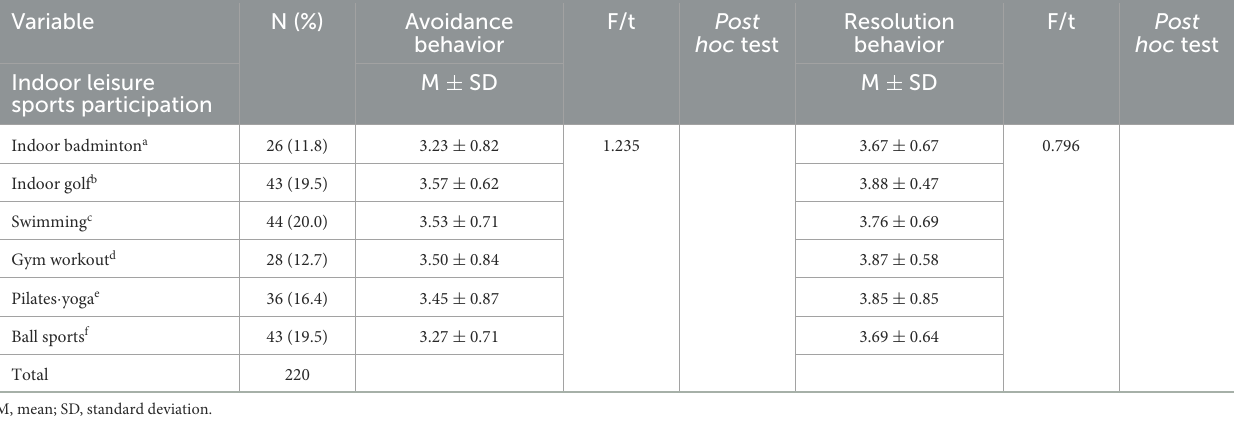
TABLE 6 Difference in coping strategies for outdoor leisure sports participation ( N =